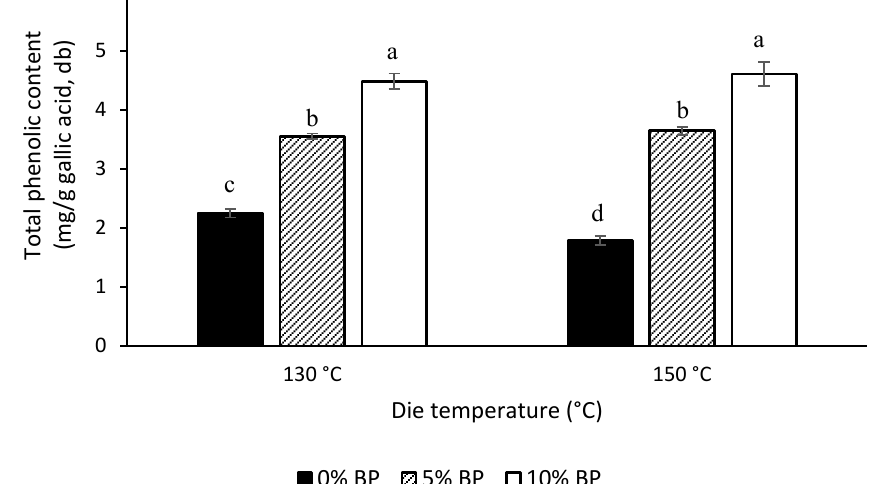
Figure 1. Total phenolic content (mean ± standard deviation) of extrudates as a function of extrusion die temperature and butterfly pea flower (BP) concentration. Bars assigned with same letters are not significantly ( p < 0.05) different ( n = 2 for extrusion, n = 3 for total phenolic content).